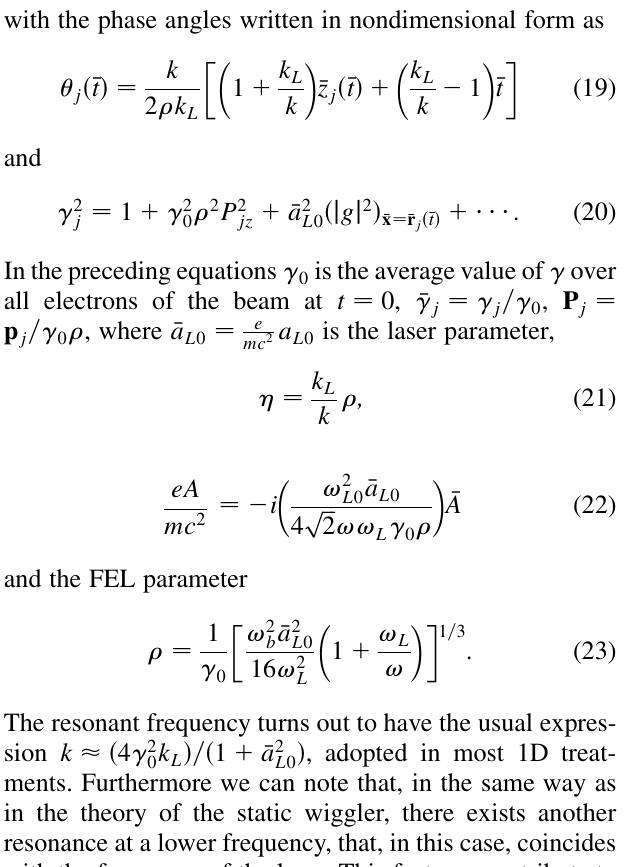
(cid:4) L 0 (cid:4) 10 (cid:1) 4 , " (cid:4) =p z z n